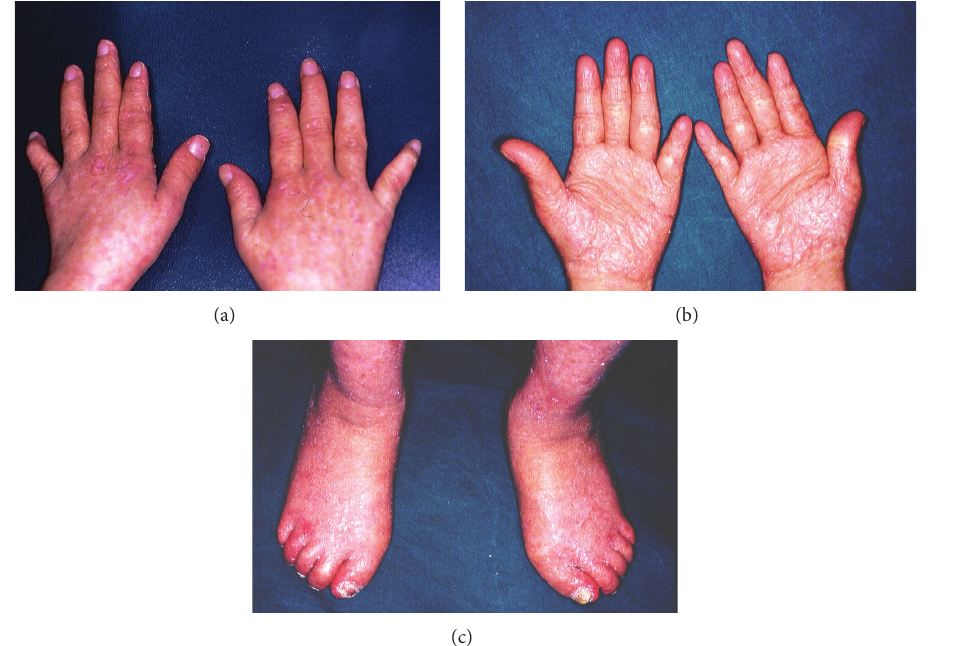
Figure 2: (a) The appearance of the outer surface of patient’s hand. (b) The hyperkeratotic appearance of the palm. (c) The hyperkeratotic appearance of the foot.